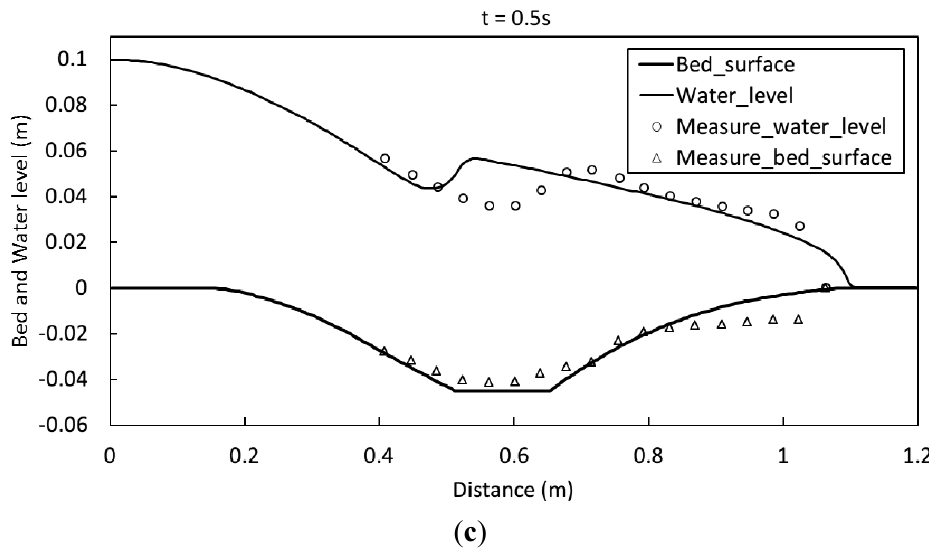
Figure 7. Comparison between simulated and measured water elevation and bed profiles.